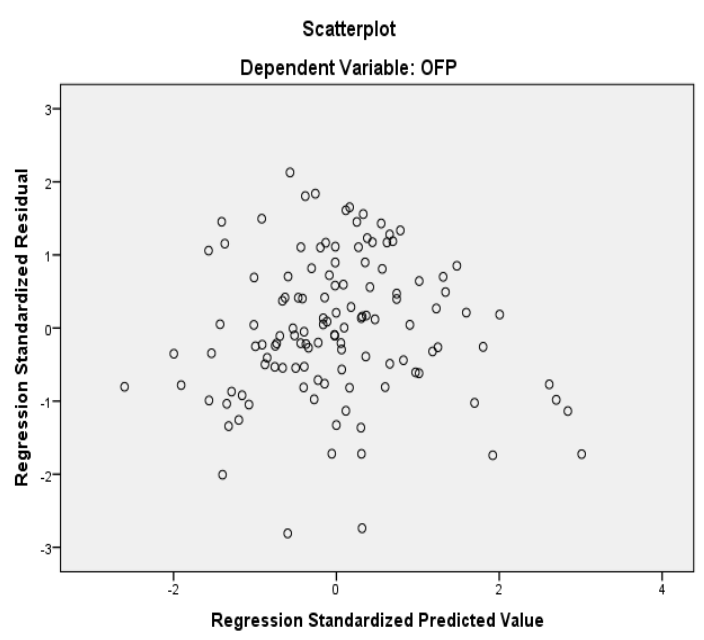
Figure A2. Scatterplot: variance of residuals. Source: Compiled by the Authors